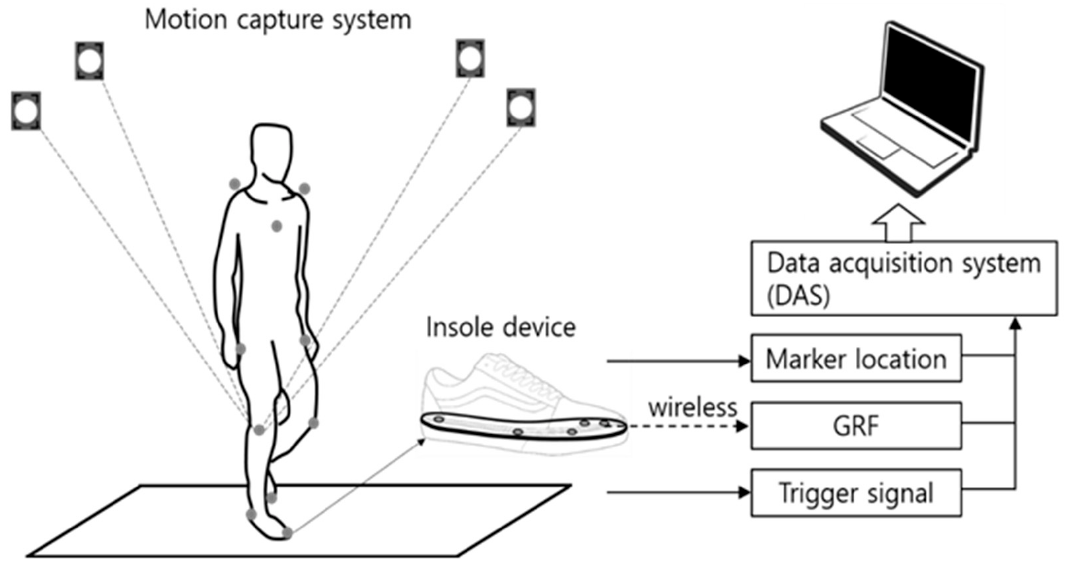
Figure 1. Experimental setup.